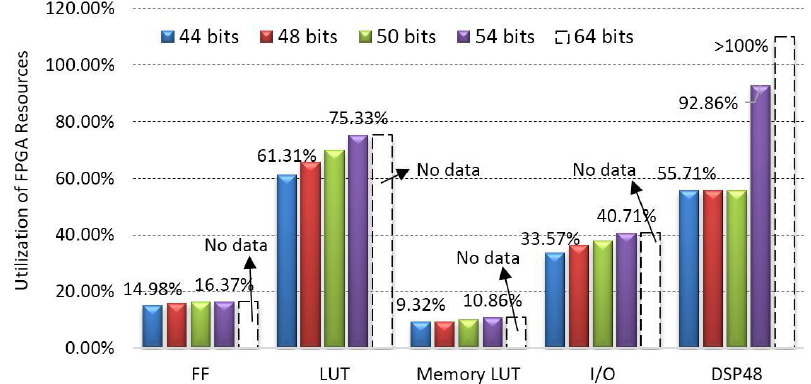
Figure 12. Comparison analysis of the utilizations of several types of FPGA resources vs. different widths of data.